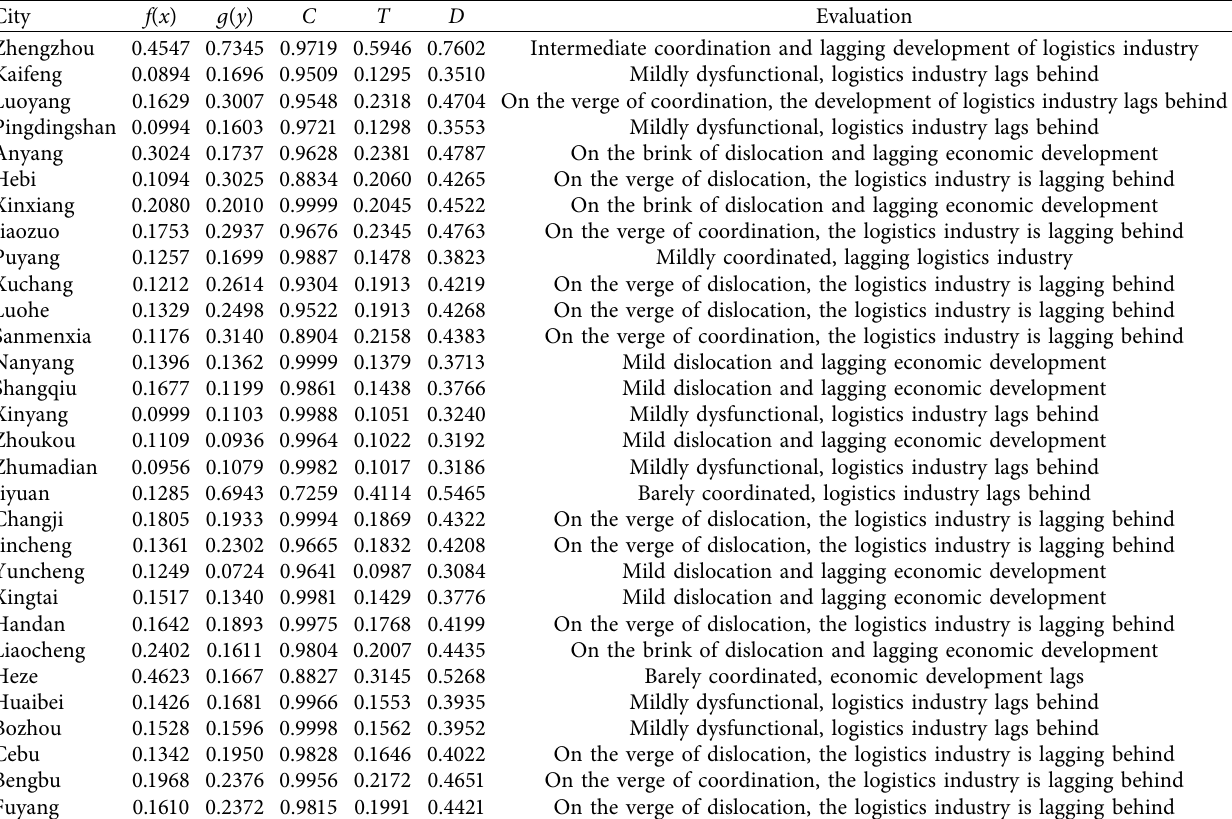
Table 3: Level of comprehensive development and coupling coordination between logistics industry and economy in Central Plains City